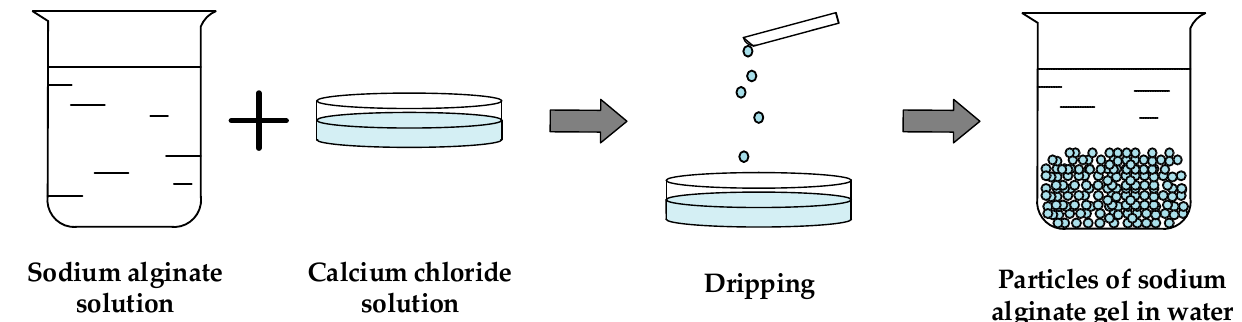
Figure 6. Schematic diagram of sodium alginate gel particles obtainment trough dripping procedure.